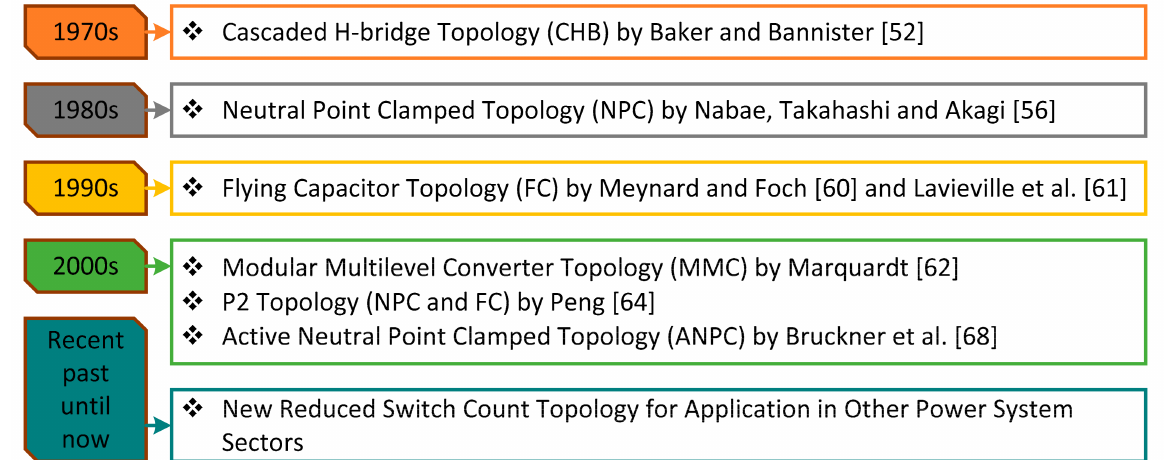
Figure 2. An outlook on the development of various MLI